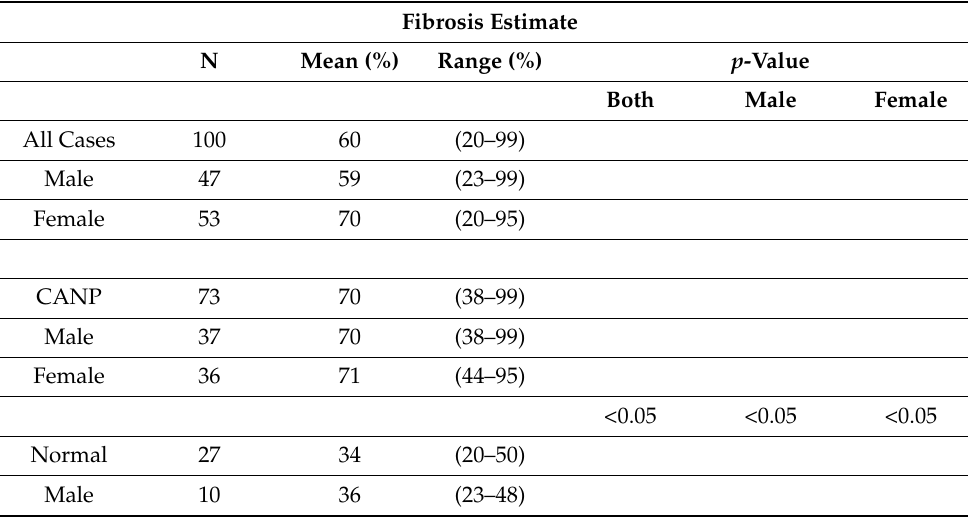
Table 3. Results of statistical analysis. CANP, chronic alcoholic and non-alcoholic pancreatitis;